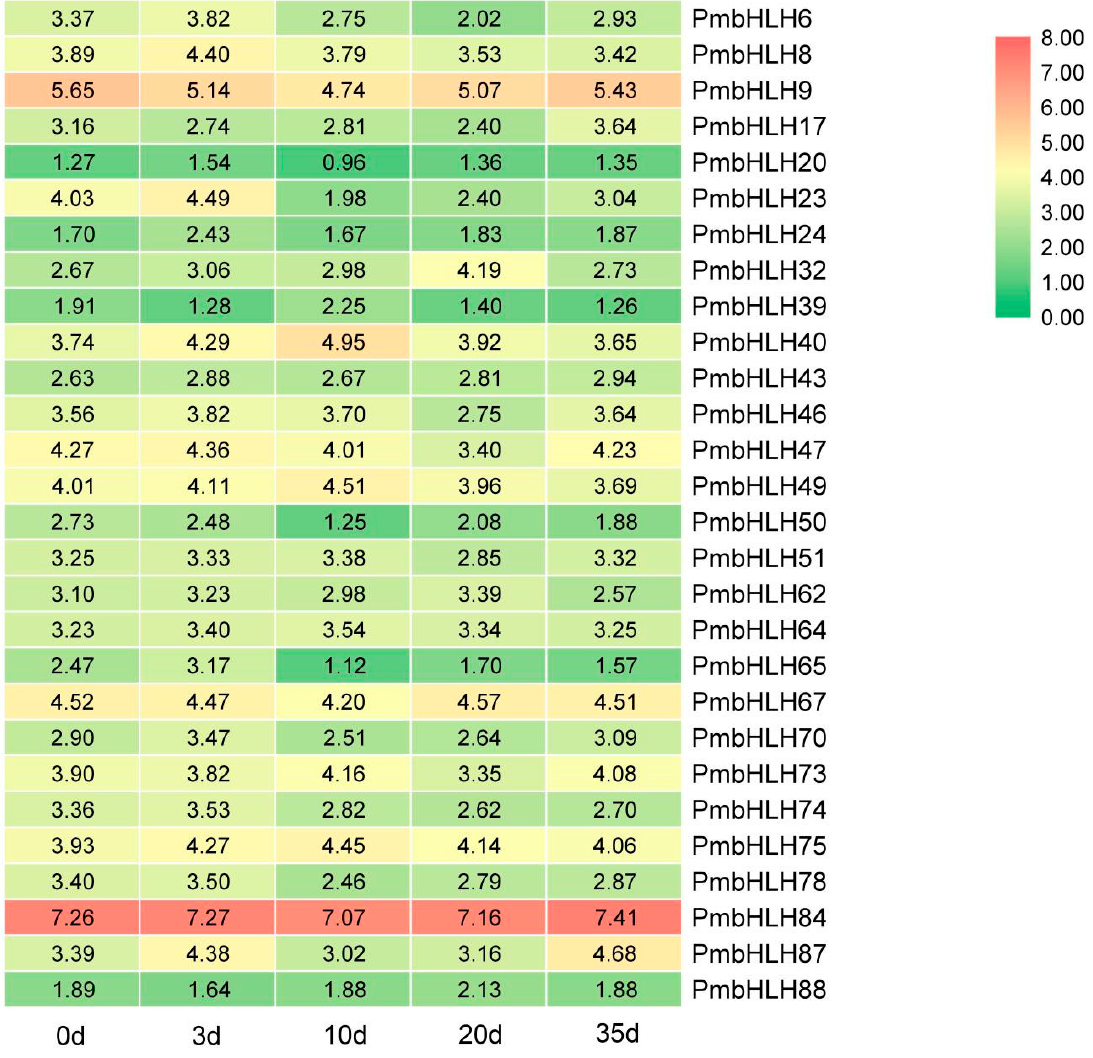
Figure 4. Transcriptional profile of bHLH genes under pine wood nematode inoculation in P. massoniana .